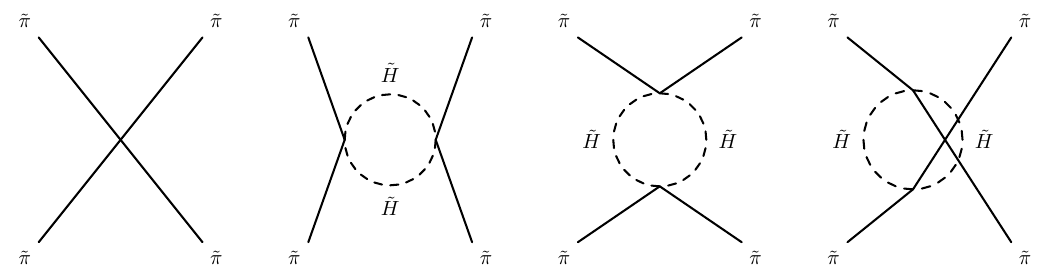
Figure 2 . ~ (cid:25) ~ (cid:25) ! ~ (cid:25) ~ (cid:25) diagrams up to 1-loop in the heavy (cid:12)eld. We emphasize that from the LEEFT picture these are all tree-level diagrams of the light (cid:12)eld. The amplitude associated with these diagrams will be denoted respectively as A 4 , A s , A t and A u